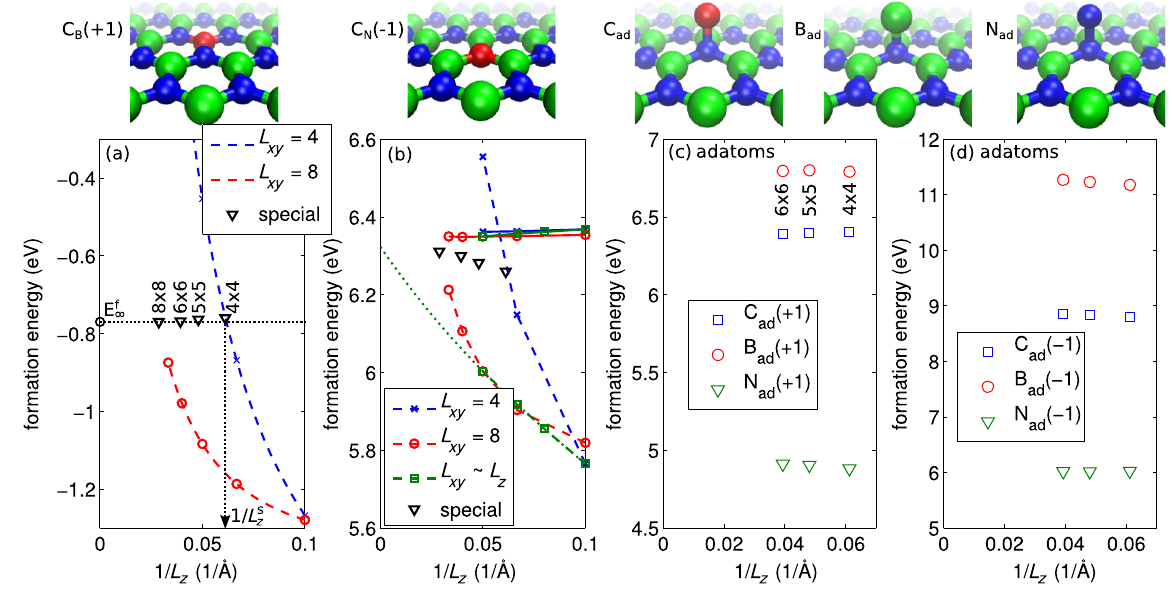
FIG. 2. (a) A schematic showing the determination of the special vacuum from the crossing point of the known E f ∞ with the curve 4 × 4 supercells for the C ðþ 1 Þ defect in h -BN. The results obtained using the special vacuums (from Table I at indicated supercell B sizes) are shown with triangles (black). (b) The uncorrected and corrected formation energies for the C Fig. 1) together with the special vacuum results. (c, d) Special vacuum formation energies for C, B, and N adatoms on h -BN at the (c) þ 1 and (d) − 1 charge states. The respective atomic geometries are visualized on top of each